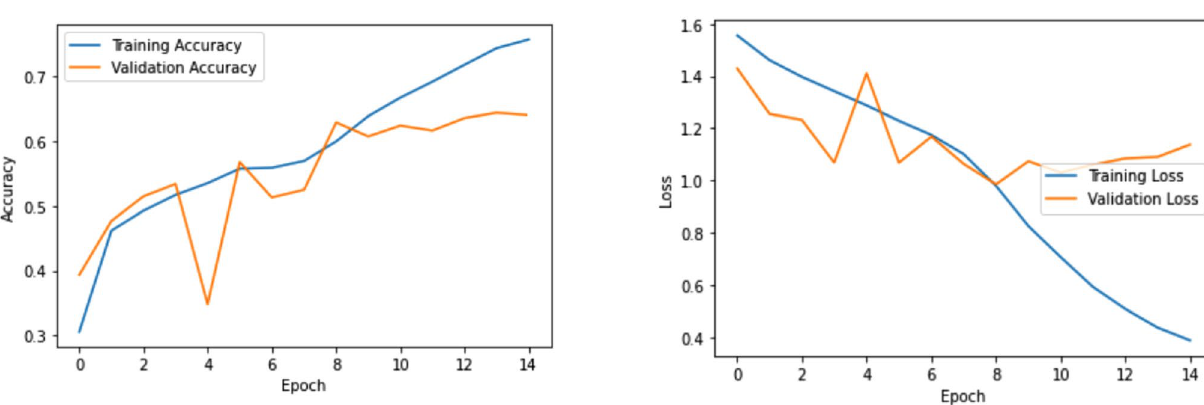
Figure 3. Training and validation accuracy and loss values for offensive language identification using adapter- BERT.